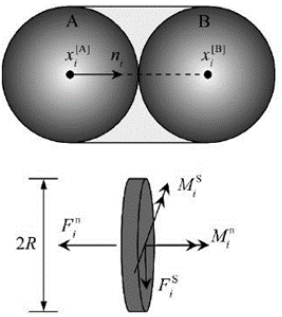
Figure 1. Parallel bonding model for spherical elements.